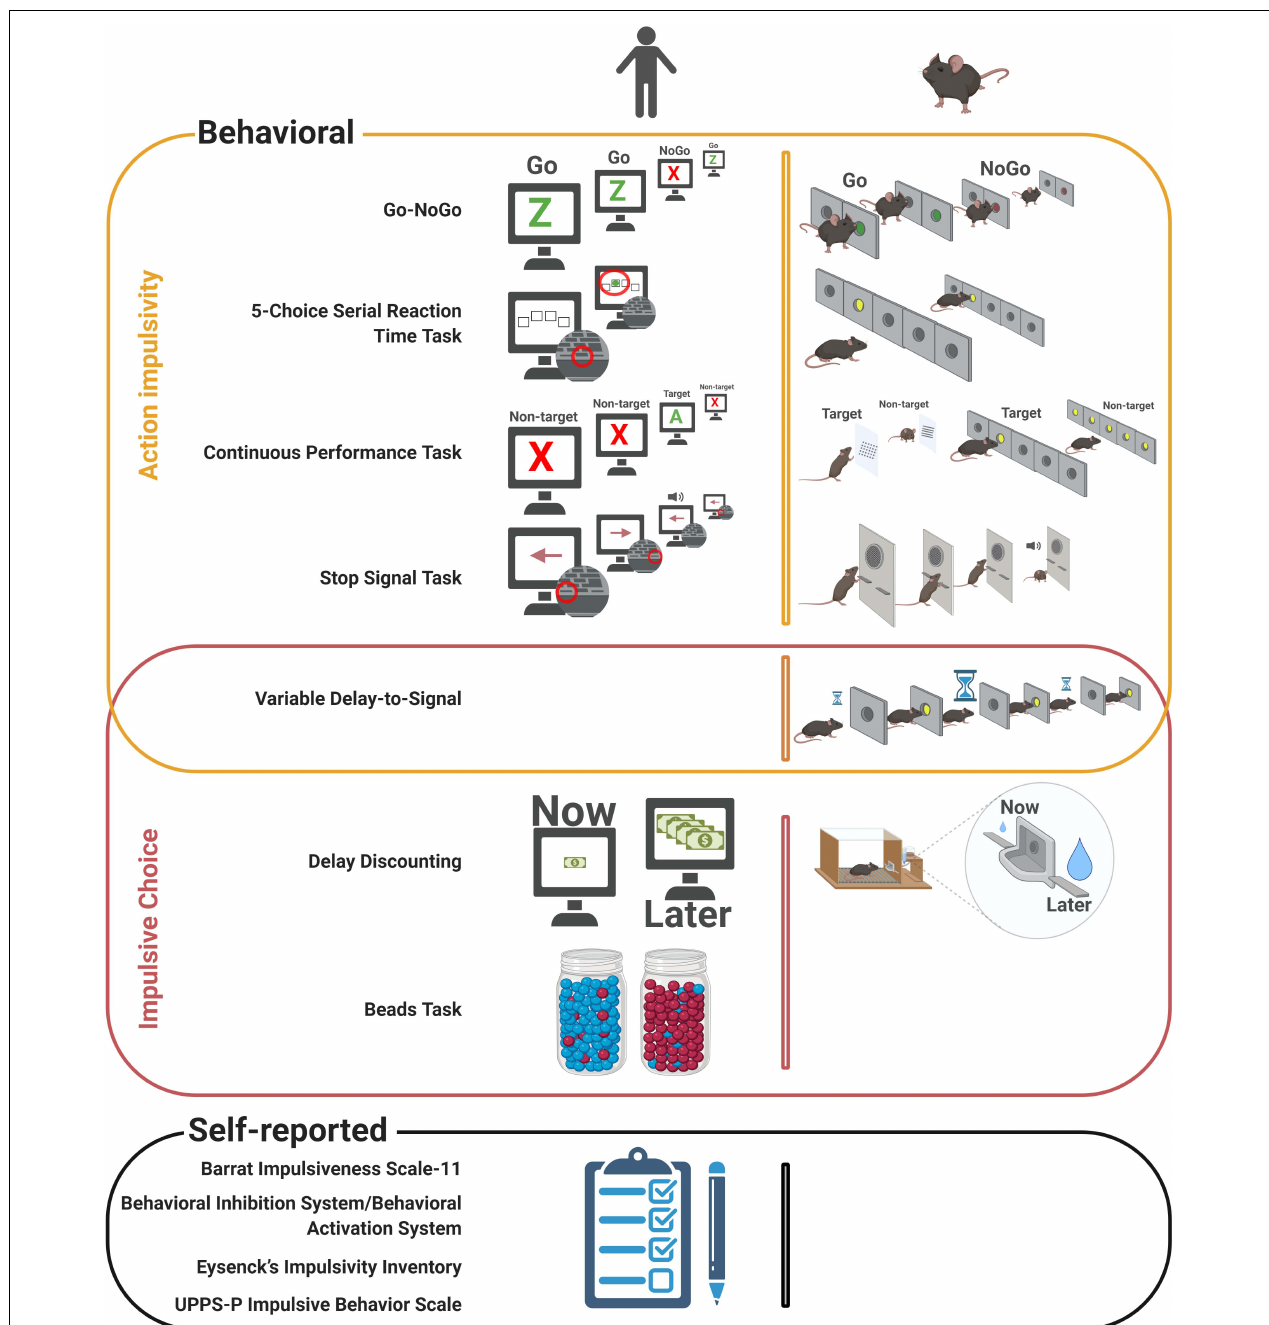
FIGURE 1 | Behavioral and self-reported measures of impulsivity. Behavioral (top) and self-reported (bottom) measures of impulsivity are shown in a schematic manner, highlighting the parallel between human (left) and rodent (right) methods. Image created with BioRender